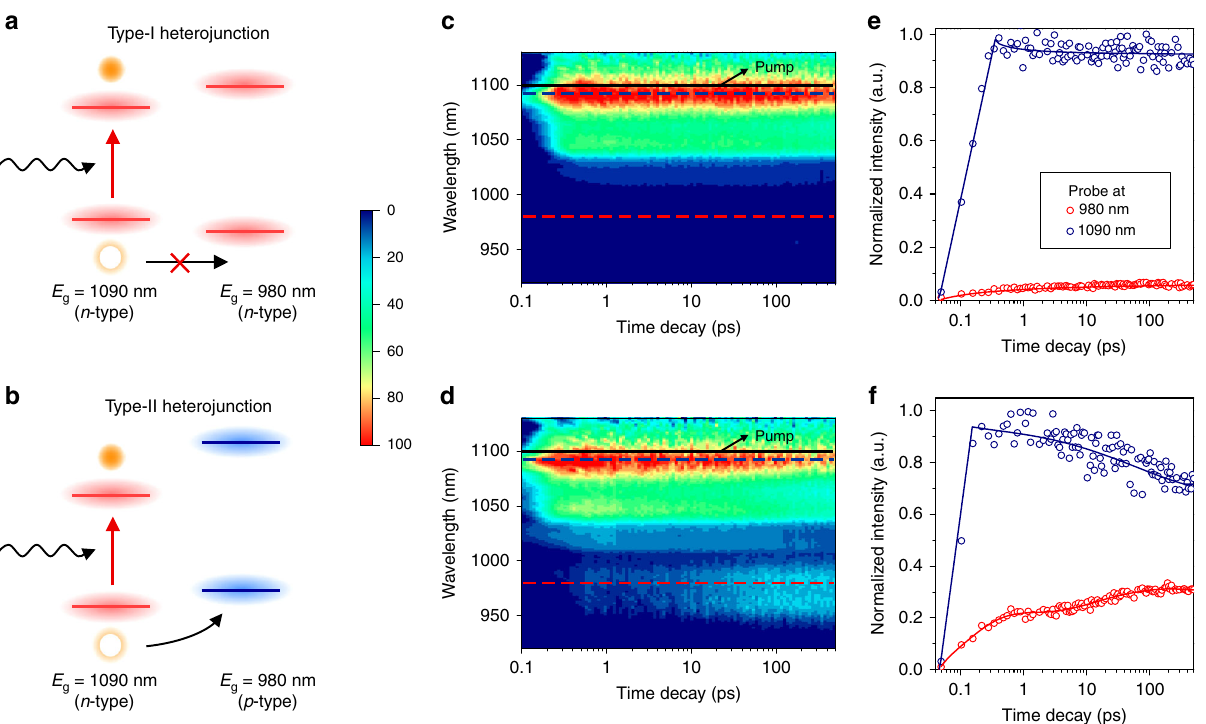
Fig. 4 Inter-dot carrier transfer in blend CQD fi lms. a , b Schematic illustration of photoexcited carrier transfer in n -type ( E g = 980 nm) – n -type ( E g = 1090 nm) blend CQD fi lm ( a ), and p -type ( E g = 980 nm) – n -type ( E g = 1090 nm) blend fi lm ( b ), when narrower E g CQDs are selectively populated by pump. c , d Transient absorption (TA) maps reveal that blending the same type of CQDs does not show carrier transfer due to type-I heterojunction formation ( c ), whereas blending different types of CQDs exhibits hole transfer owing to formation of type-II heterojunction ( d ). e , f TA spectral kinetic traces of bandedge exciton bleaching signals at each E g position for ( c ) and ( d ),